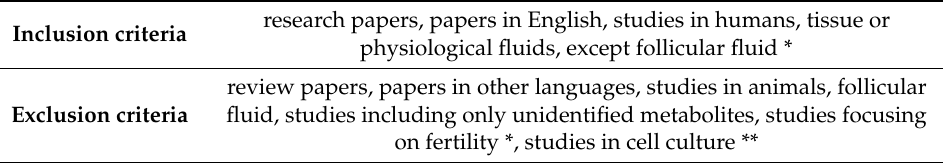
Table 2. Inclusion and exclusion criteria.